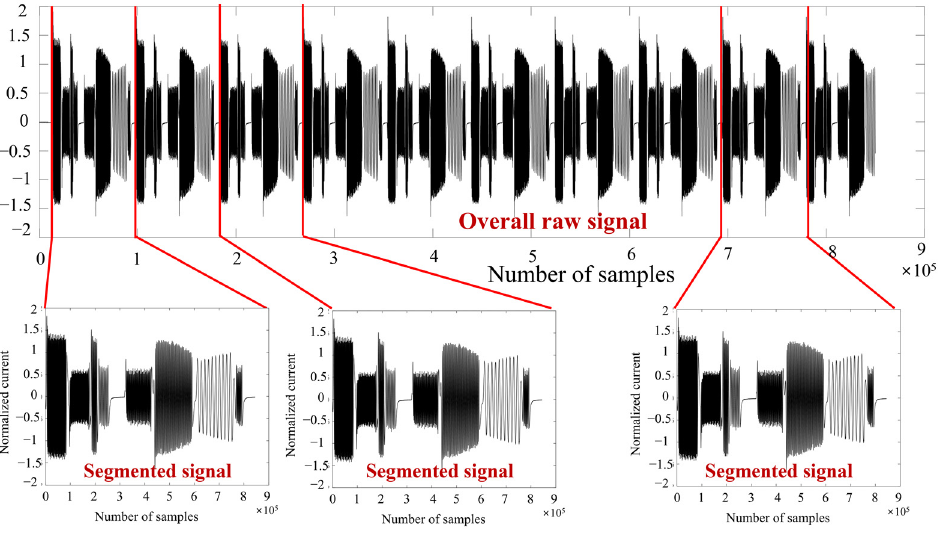
Figure 4. Data segmentation process for the raw